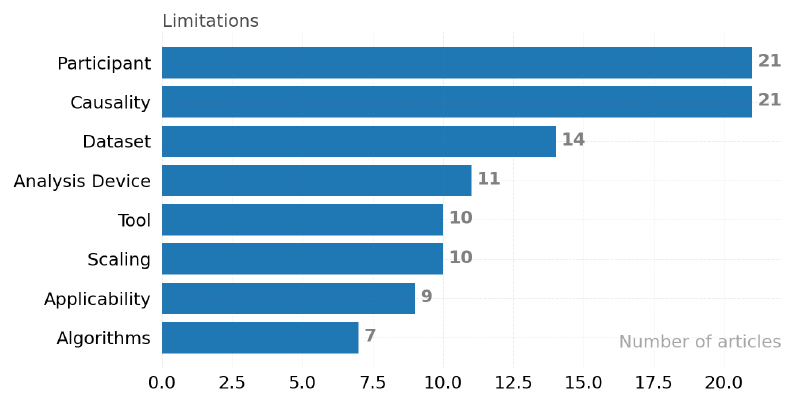
Figure 17. Distribution of the reported limitations by